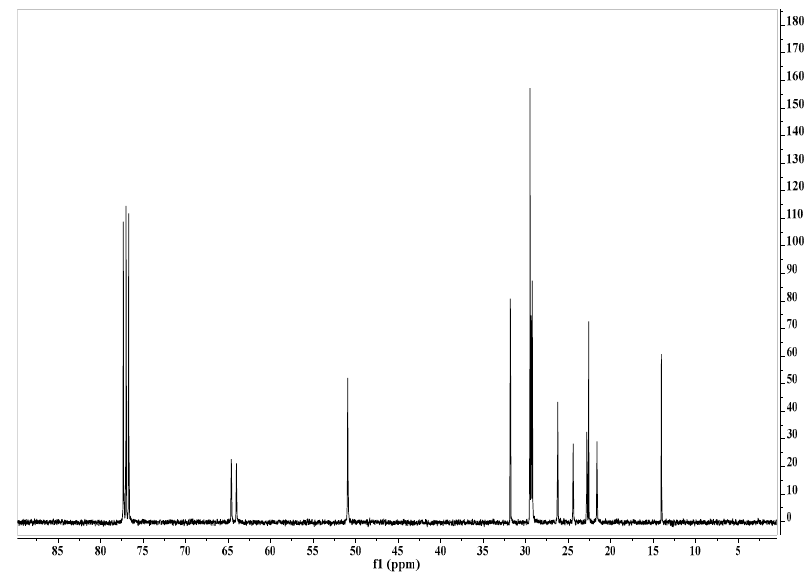
Figure 4. 13 C-NMR spectrum of hexamethylene-1,6-bis( N , N -dimethyl- N -dodecylammonium bromide) in CDCl 3 . Table 2. The characteristics of the structures used to prepare SPBS.